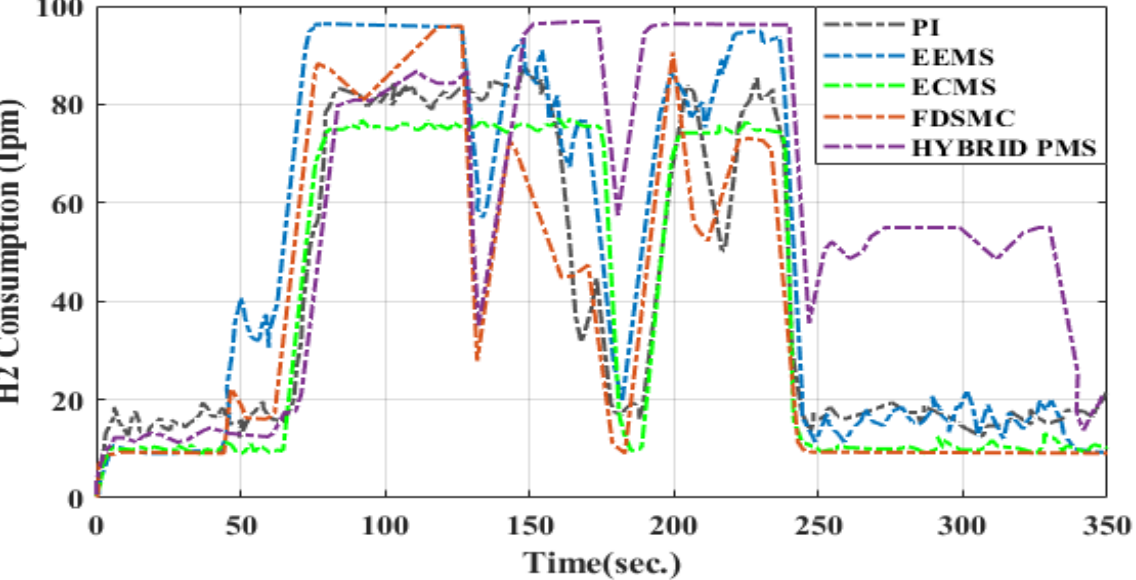
Figure 17. Hydrogen consumption in Ipm for studied approaches (WLTP—Class 3 Drive Cycle).